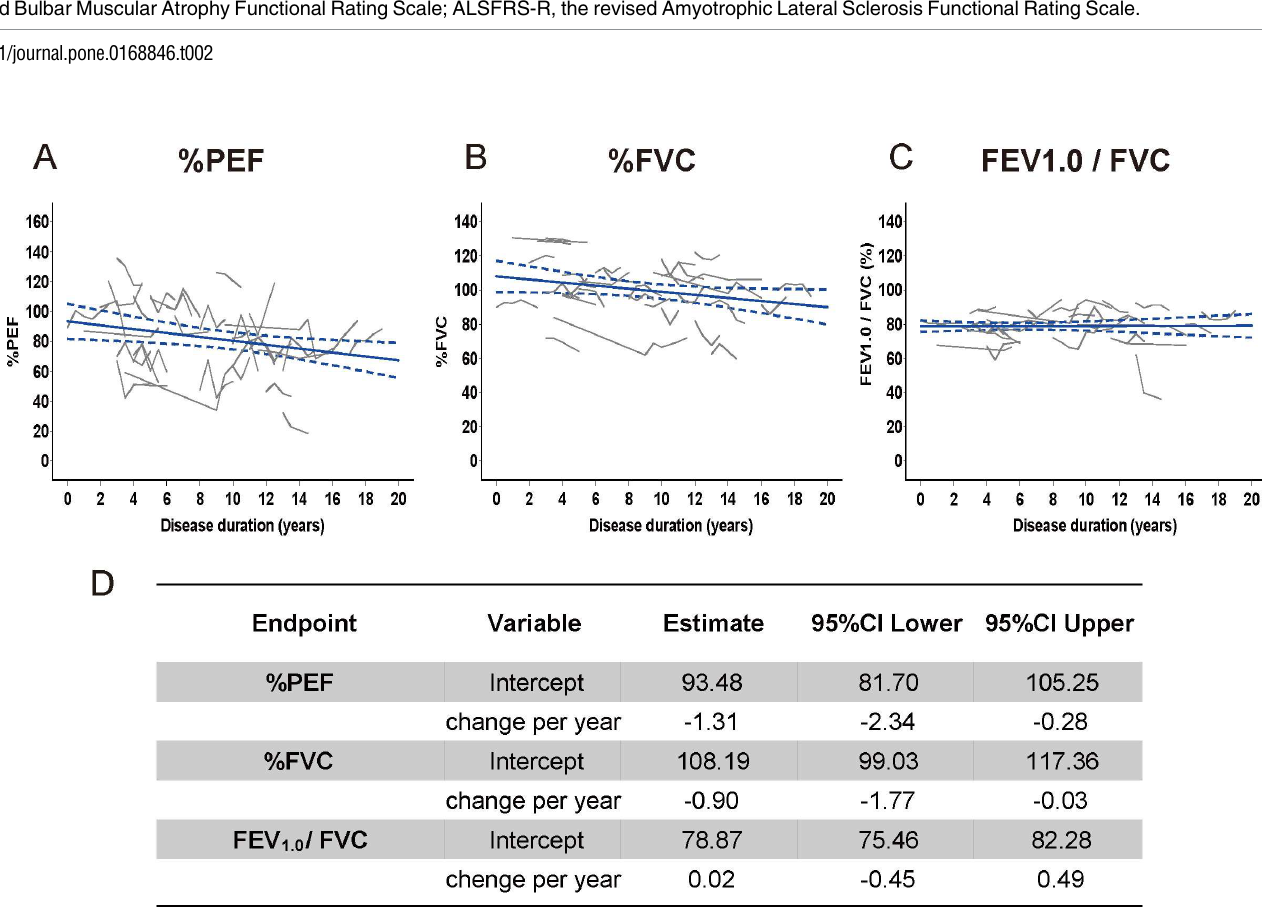
Fig 3. Longitudinal changes in respiratory function in SBMA. Longitudinal changesin %PEF (A), %VC (B), and FEV 1.0 /FVC (C) as a function of diseasedurationwere analyzed.The solid lines indicaterepresentative diseaseprogressionover diseasedurationcalculatedusing a marginal model under an unstructured covariancematrix. The broken curvilinear line demonstrates the 95% confidenceintervalof these models. We calculatedthe estimated values at clinicalonset (intercepts) and the changevalues per year (D). In an analysisusing the marginalmodel, a generalizedestimatingequation (shown by the solid lines) identifiedthat %PEF (A) and %FVC (B) demonstrated a slowly but with steady progression. PEF, peak expiratory flow; FVC, forced vital capacity; FEV 1.0 , forced expiratory volume in 1